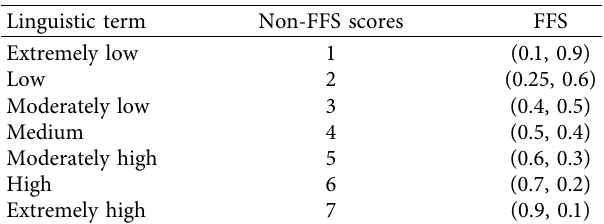
Table 3: Linguistic evaluation